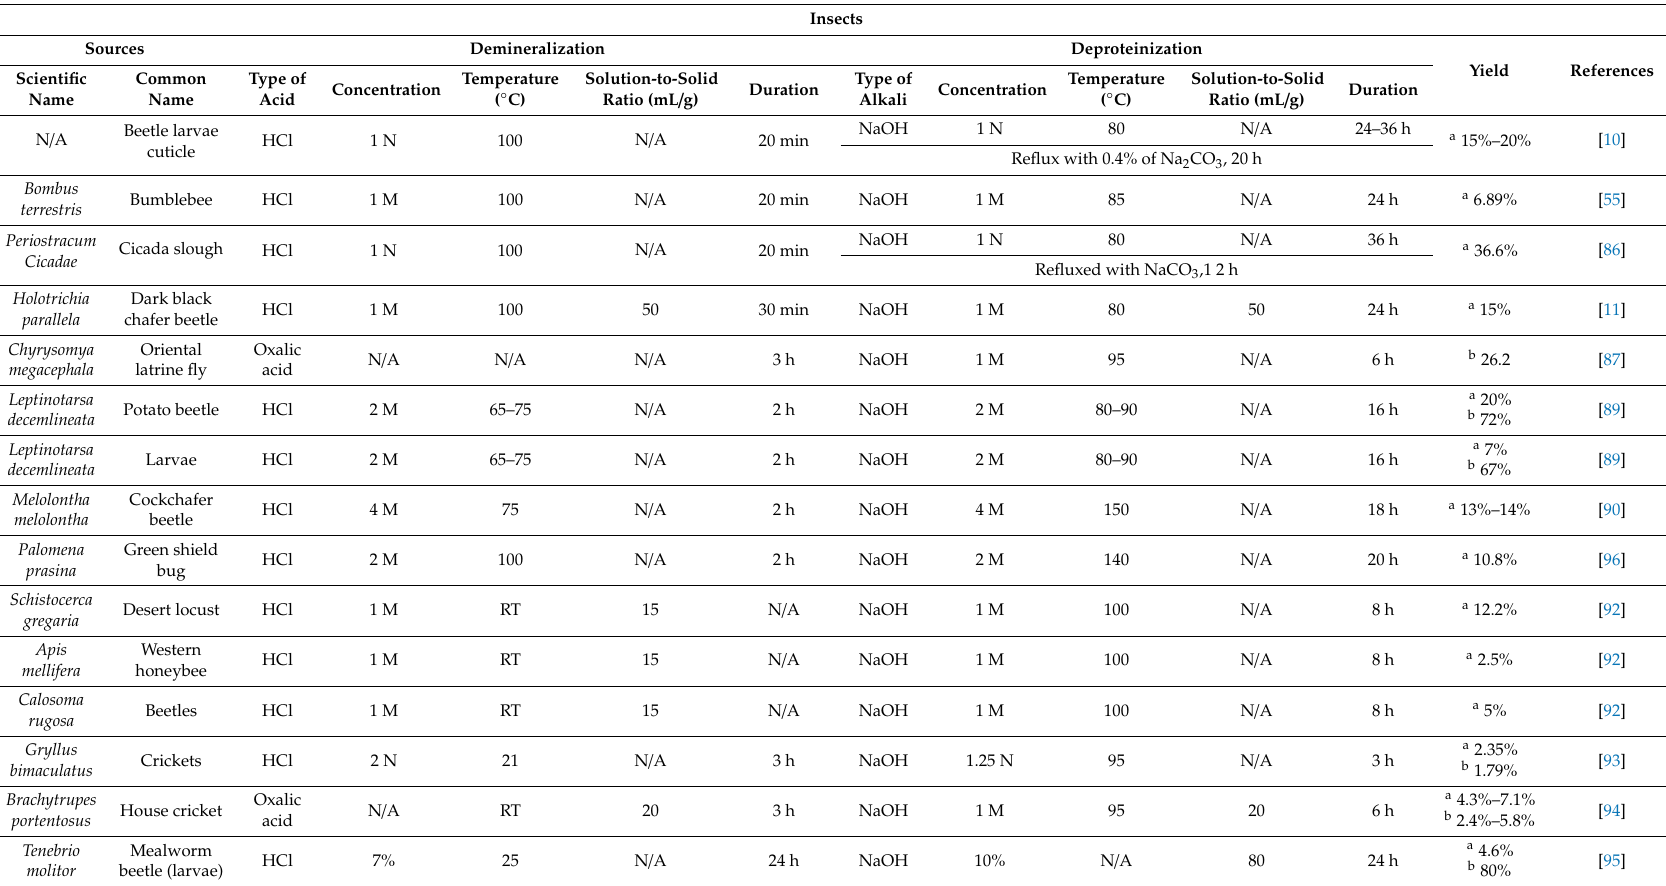
Table 1. A summary of the demineralization and deproteinization of chitin and chitosan from insects.